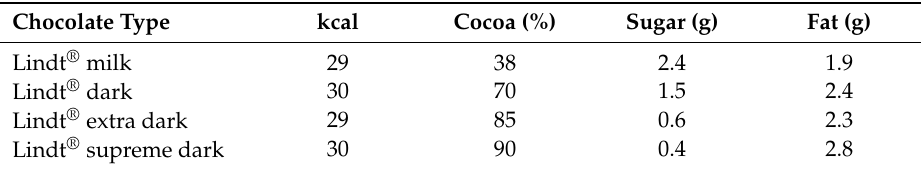
Table 2. Characteristics of each 5 g chocolate